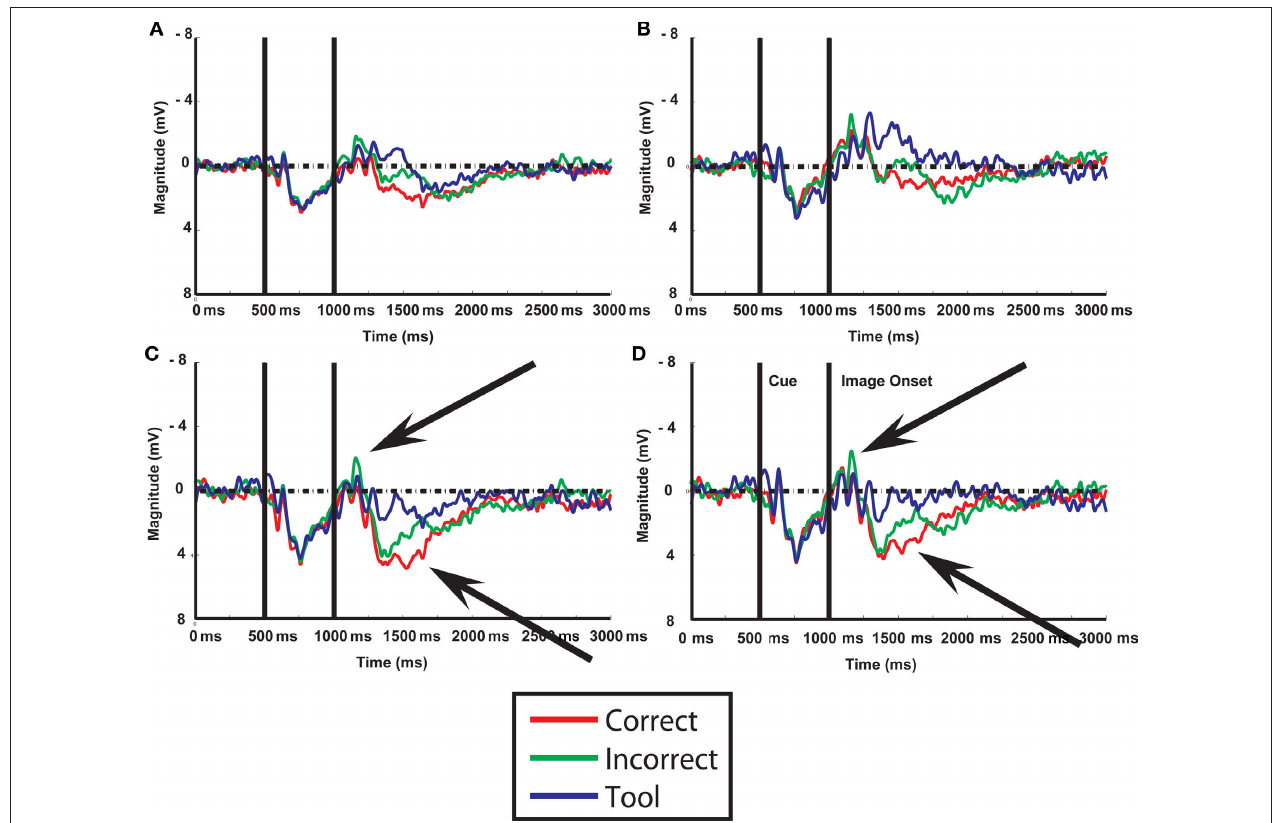
vertical line). Conditions are indicated by different color tracings, as specified to the bottom of the figure. Arrows indicate clear divergence of waveforms in correct and incorrect